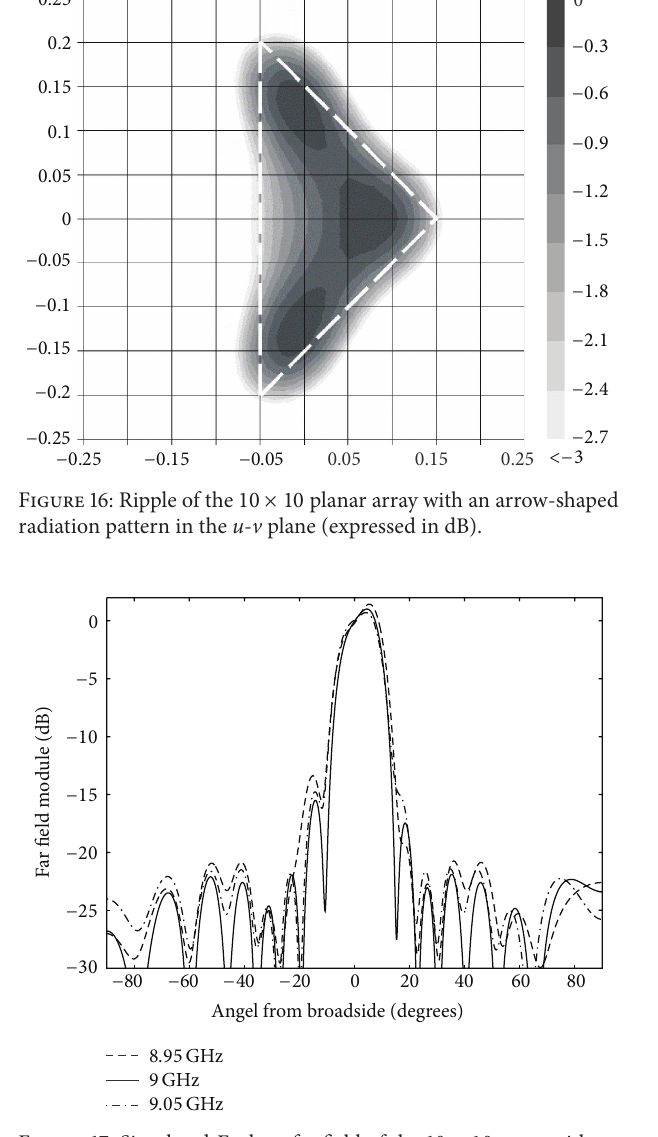
Figure 17: Simulated 𝐸 -plane far field of the 10 × 10 array with an arrow-shaped radiation pattern.